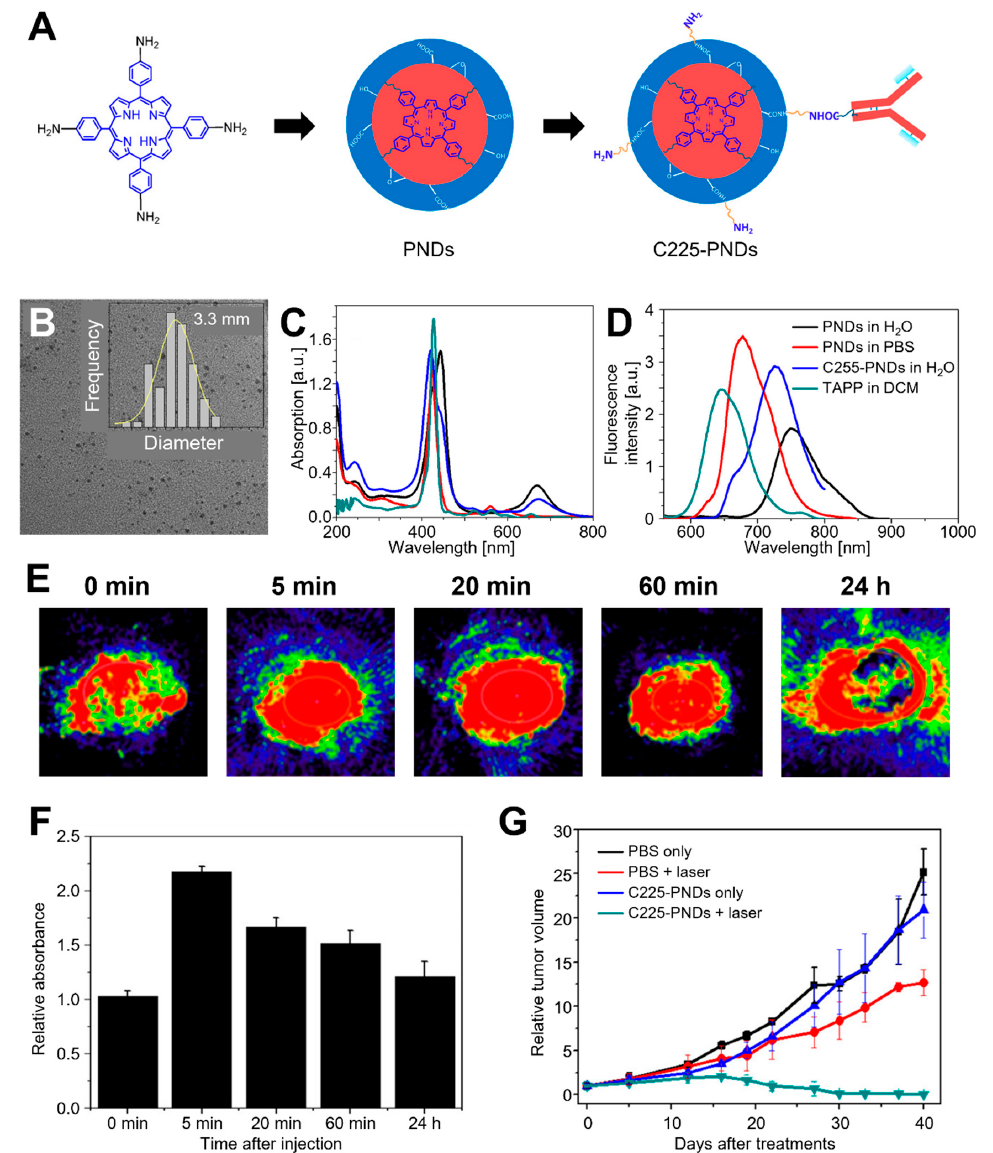
Figure 8. C225–PNDs for PAI and in vivo breast cancer ablation. ( A ) Proposed formation pathway of PNDs and the synthetic routes of C225–PNDs. ( B ) TEM image of PNDs with a corresponding size distribution histogram. ( C ) UV–vis spectra and ( D ) emission spectra ( λ ex = 440 nm) of PNDs, C225– PNDs, and 5,10,15,20-tetrakis (4-aminophenyl) porphyrin (TAPP). ( E ) PA imaging and ( F ) relative PA intensity of C225–PNDs in the tumor at different time points. ( G ) Relative tumor volume. The images are reproduced with permission from ref. [165].